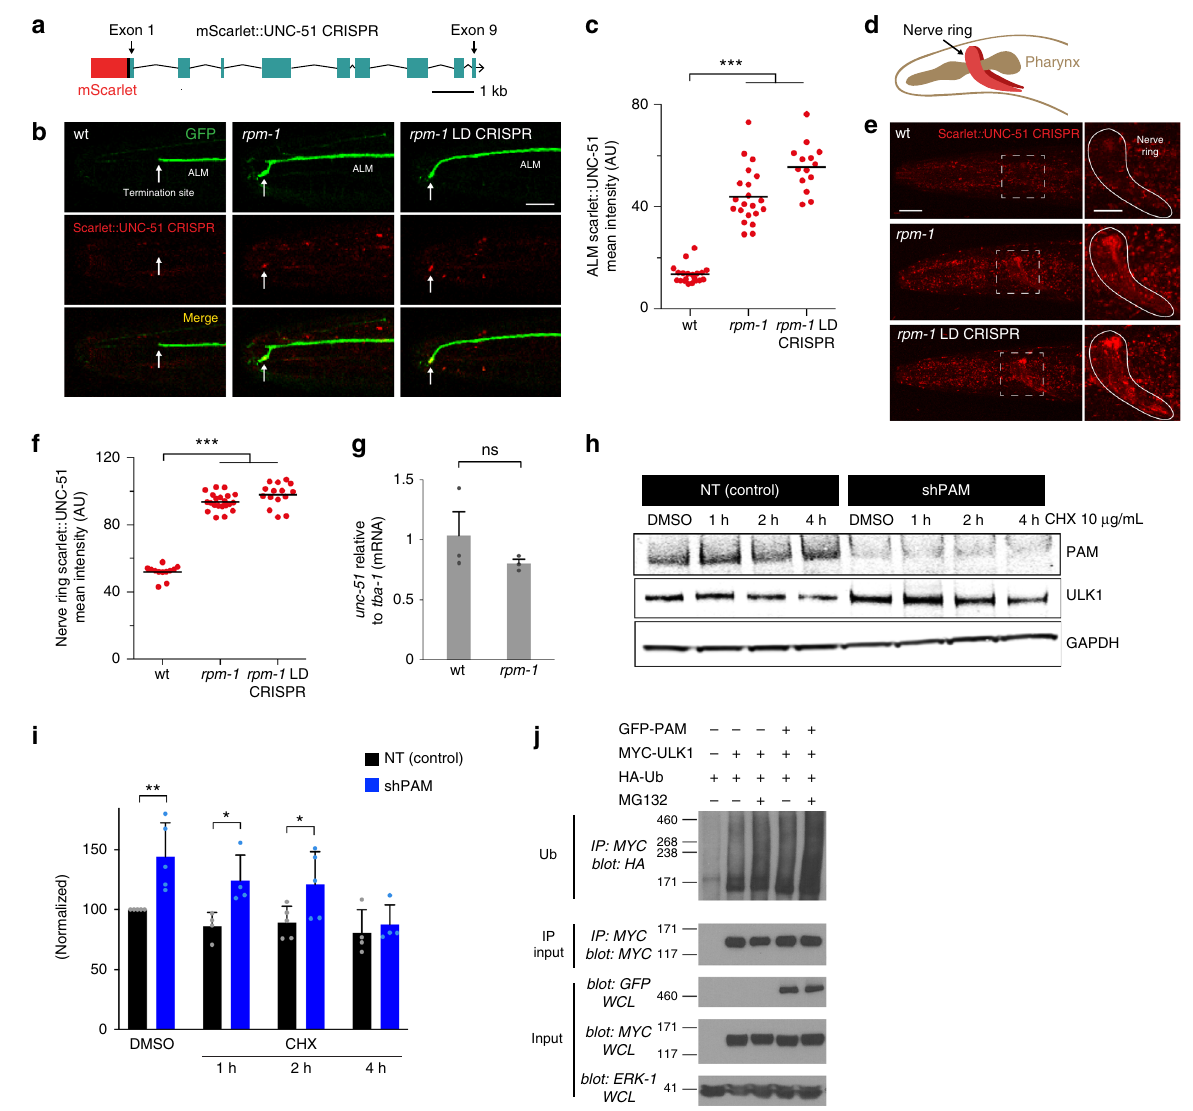
Fig. 5 RPM-1 restricts UNC-51 levels in axonal compartments, broadly across the nervous system, and has conserved effects on human ULK1. a Diagram showing CRISPR engineering of mScarlet into C. elegans unc-51 gene. b Representative confocal images showing mScarlet::UNC-51 CRISPR in axons of ALM neurons for indicated genotypes. Transgenic GFP is used to visualize axon termination site (white arrow). In rpm-1 (lf) mutants and rpm-1 LD CRISPR animals, mScarlet::UNC-51 accumulates in puncta at the tips of axons with failed termination (white arrows). Scale bar 10 μ m. c Quantitation indicates mScarlet::UNC-51 is signi fi cantly increased at tips of axons in rpm-1 (lf) mutants and rpm-1 LD CRISPR mutants compared with wt animals. d Schematic showing axon bundle in the nerve ring of C. elegans . e Representative confocal images showing mScarlet::UNC-51 CRISPR in nerve ring for indicated genotypes. mScarlet::UNC-51 is increased in nerve ring of rpm-1 (lf) mutants and rpm-1 LD CRISPR animals. Scale bars 20 μ m (zoom-out, left), 10 μ m (zoom-in, right). f Quantitation showing mScarlet::UNC-51 is signi fi cantly increased in nerve ring of rpm-1 (lf) mutants and rpm-1 LD CRISPR mutants compared to wt animals. g Quantitation indicates unc-51 mRNA levels are unchanged in rpm-1 mutants compared to wt. h Representative western blots from human SH-SY5Y neuroblastoma cells showing endogenous ULK1 is increased when cells are infected with lentivirus expressing shRNA against human PAM . ULK1 increases caused by PAM knockdown are also observed when translation is inhibited with cycloheximide (CHX). i Quantitation shows ULK1 levels are signi fi cantly elevated when PAM is knocked down in SH-SY5Y. Shown are means with SEM from four independent experiments. j GFP-PAM polyubiquitinates MYC-ULK1 in HEK 293 cells. PAM polyubiquitination of ULK1 is increased when the proteasome is inhibited with MG132. Shown is a representative of three independent experiments. For c and f , means are shown from 12 or more animals imaged during 3 – 4 independent experiments for each genotype, and signi fi cance was determined using Student ’ s t test with Bonferroni correction. For i , signi fi cance was tested using two-way ANOVA with post hoc Student ’ s t test. * p < 0.05, ** p < 0.01, *** p < 0.001. Source data are provided as a Source Data fi species (e.g. tubulin tba-1 ) in rpm-1 mutants compared with wt animals (Fig. 5g; Supplementary Fig. 8). Thus, effects of RPM-1 on UNC-51 are not due to changes in unc-51 transcription.